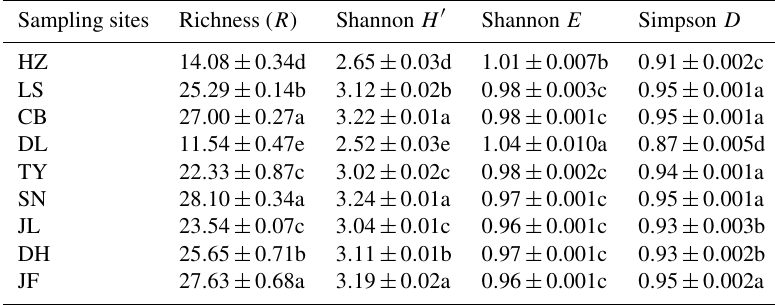
Table 3. Functional diversity of soil microbial communities in forest ecosystems along the NSTEC. Sampling sites